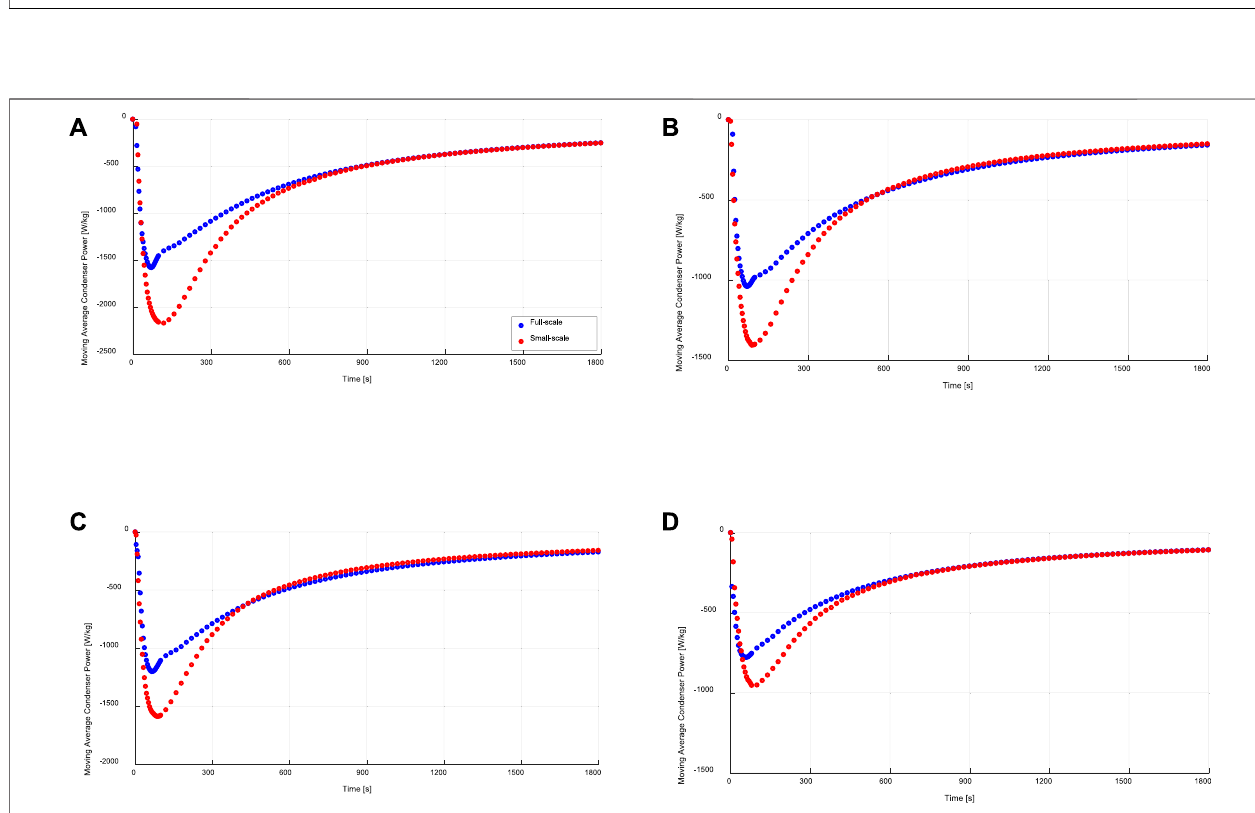
Frontiers in Energy Research |